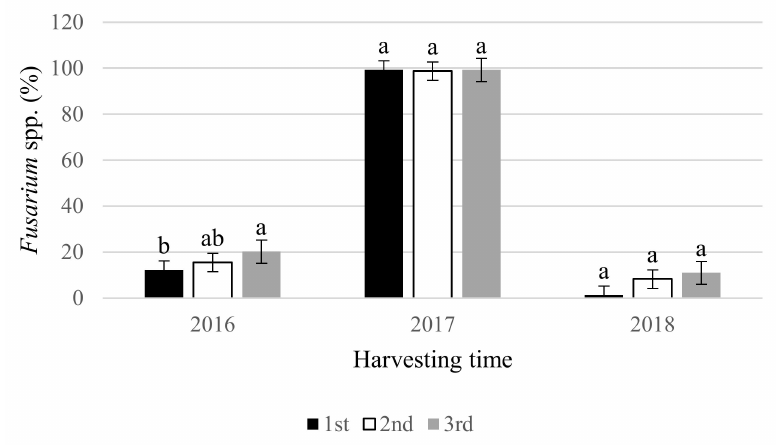
Figure 2. Fusarium spp. (%) in spring wheat grain at different harvesting times. Note. Values followed by the same letter for each year are not significantly different (Duncan’s multiple-range test, p < 0.05); 1st—harvesting time when wheat reached full maturity, BBCH 89; 2nd—full maturity + 10 ± 2 days; 3rd—full maturity + 17 ± 3 days.